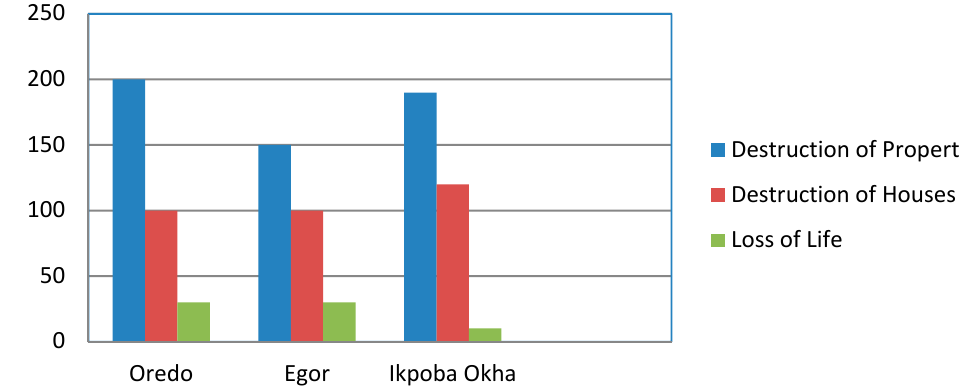
Figure 4. Flood loss, hazard, and damage in Benin City in the previous 19-year period.